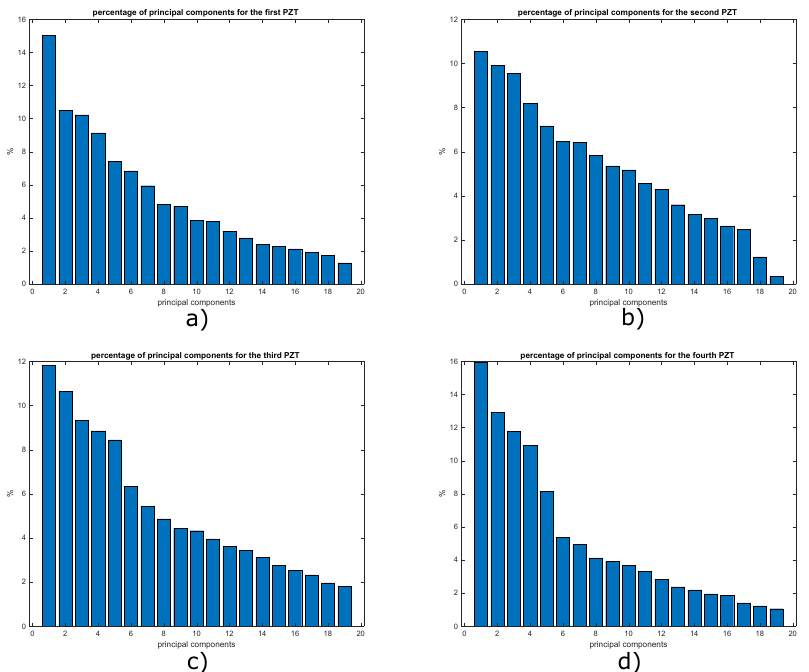
Figure 16. Variance distribution in: ( a ) phase 1; ( b ) phase 2; ( c ) phase 3 and ( d ) phase